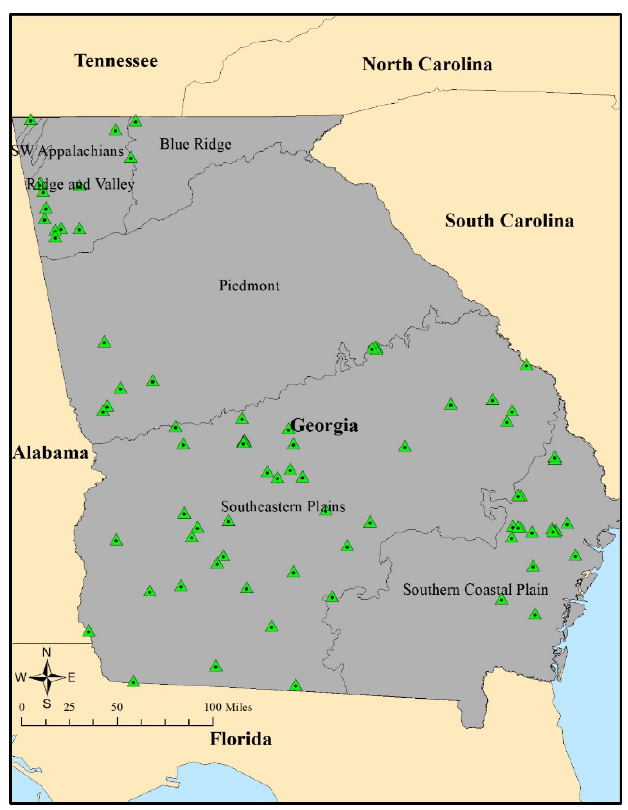
Figure 1. Map of Georgia with easement locations of WFCEs identified in this study.